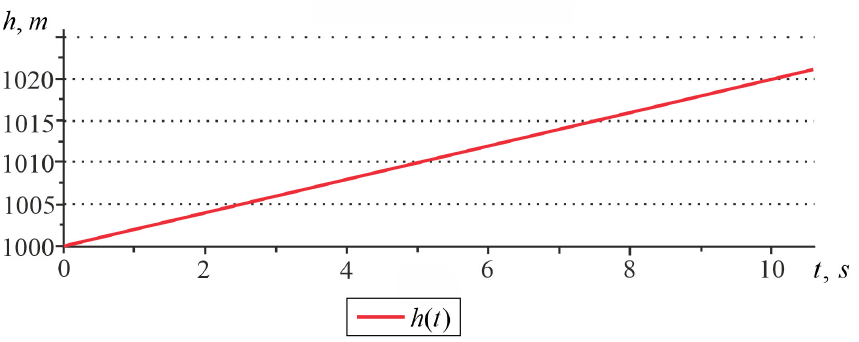
Figure 7. Height estimation (first simulation).